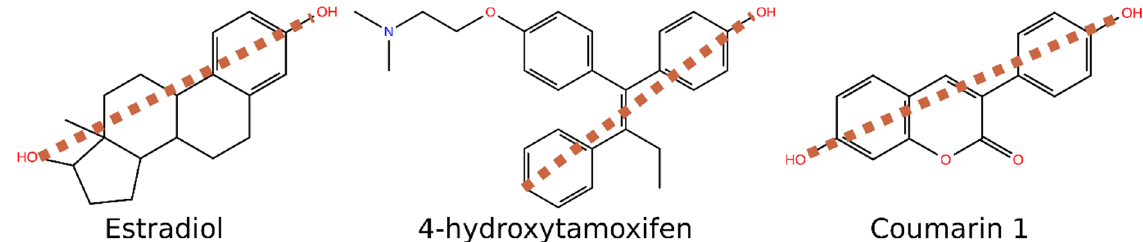
Figure 4. Simple 2D molecular topology pharmacophore for ER binders. Estradiol, 4-hydroxytamoxifen, and 3-phenylcoumarin core divide equally when a line is drawn from the A-ring/3-phenyl ring to the other end of the compound.